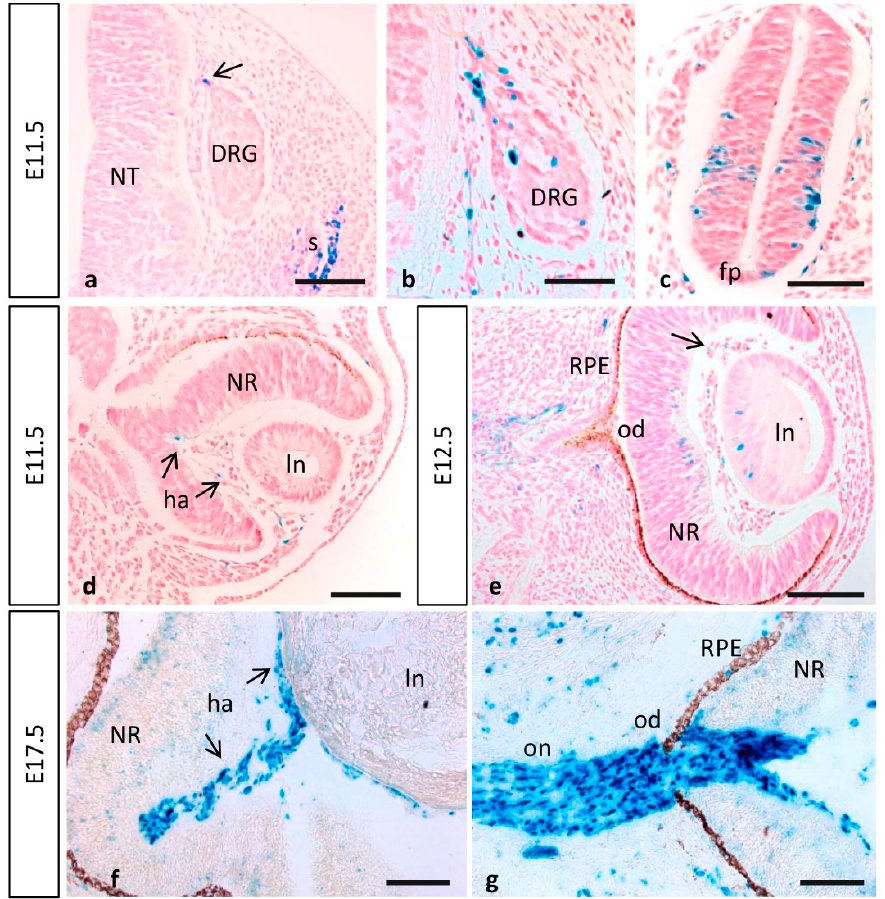
Figure 7. MT1-MMP expression in the embryonic spinal cord and eye. ( a , b ) MT1-MMP expression was detected in the spinal cord particularly in neural crest cells, somites, the dorsal nerve root and the dorsal root ganglia at E11.5. Reporter expression was also observed in neural precursors of the spinal cord and the floor plate ( c ). ( d , e ) In the developing eye, β -gal positive cells localize in the hyaloid artery at E11.5 (arrows in d ) and E12.5 (arrow in e ). Further, scattered cells were detected in the lens and the neural retina by E12.5 ( e ). Later in development, MT1-MMP expression increases in the hyaloid artery and is present in cells surrounding the optic nerve and at the level of the optic disc and optic nerve head, possibly corresponding to glial cells ( f , g ). Abbreviations: DRG, dorsal root ganglia; fp, floor plate; ha, hyaloid artery; od, optic disc; on, optic nerve; ln, lens; NR, neural retina; NT, neural tube; RPE, retinal pigmented epithelium. Scale bars: 100 µm ( a – g ). MT1-MMP positive signal at the level of NCCs is in the direction of previous